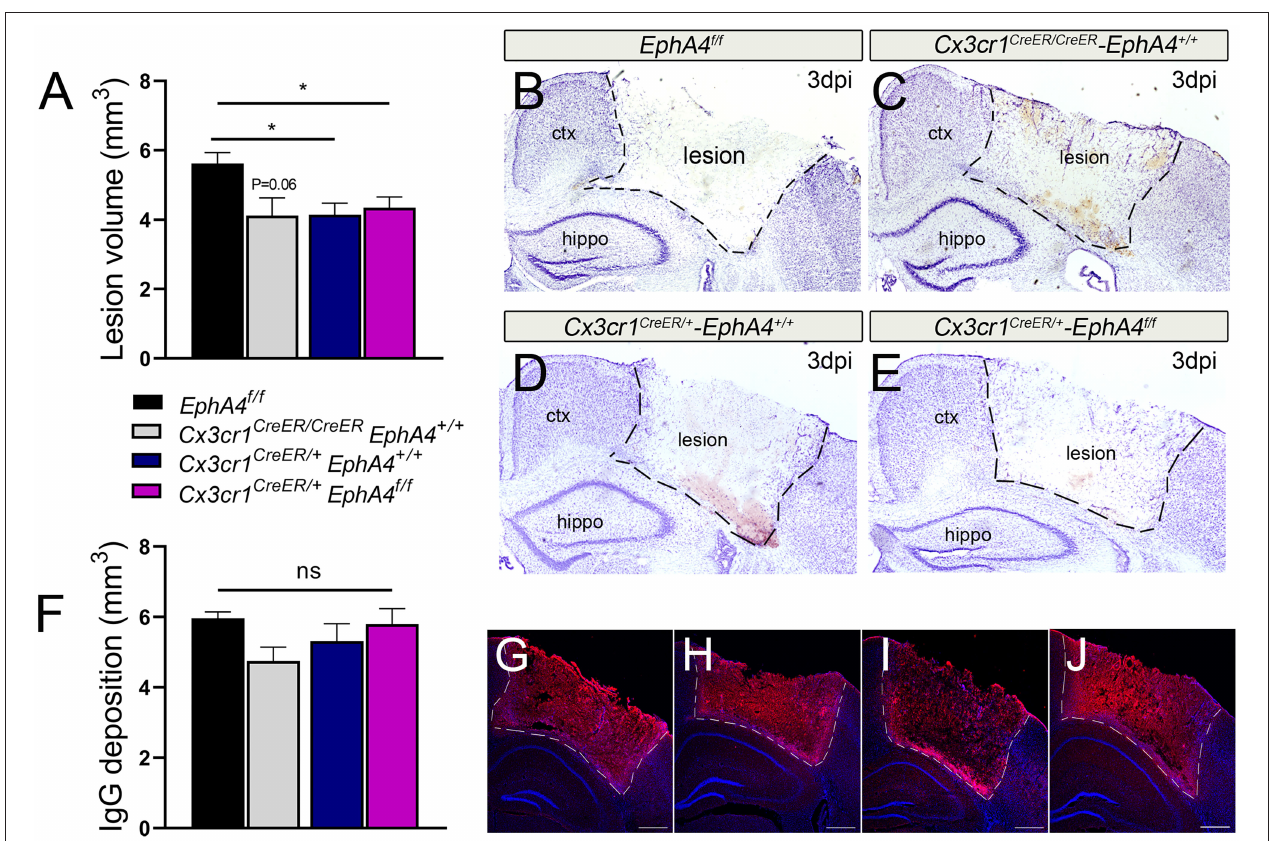
FIGURE 5 | Conditional deletion of microglial EphA4 does not affect acute tissue damage or BBB disruption, following CCI injury. (A) Lesion volume (mm 3 ) 3 dpi was estimated in the ipsilateral cortex of five Nisslstained serial coronal sections of each brain using Cavalieri Estimator from StereoInvestigator. (B–E) Representative mosaic images for the ipsilateral cortices of Nissl-stained sections taken at 4 × magnification. (F) Immunoglobulin G (IgG) deposition volume was measured at 3 dpi in the ipsilateral cortex of five serial coronal sections of each brain using Cavalieri Estimator from StereoInvestigator. (G–J) Representative confocal images for the ipsilateral cortices of anti-mouse IgG-stained sections (red) taken at 4 × magnification. N = 5–15, * p < 0.05, significant difference between the designated groups. ns, nonsignificant difference was